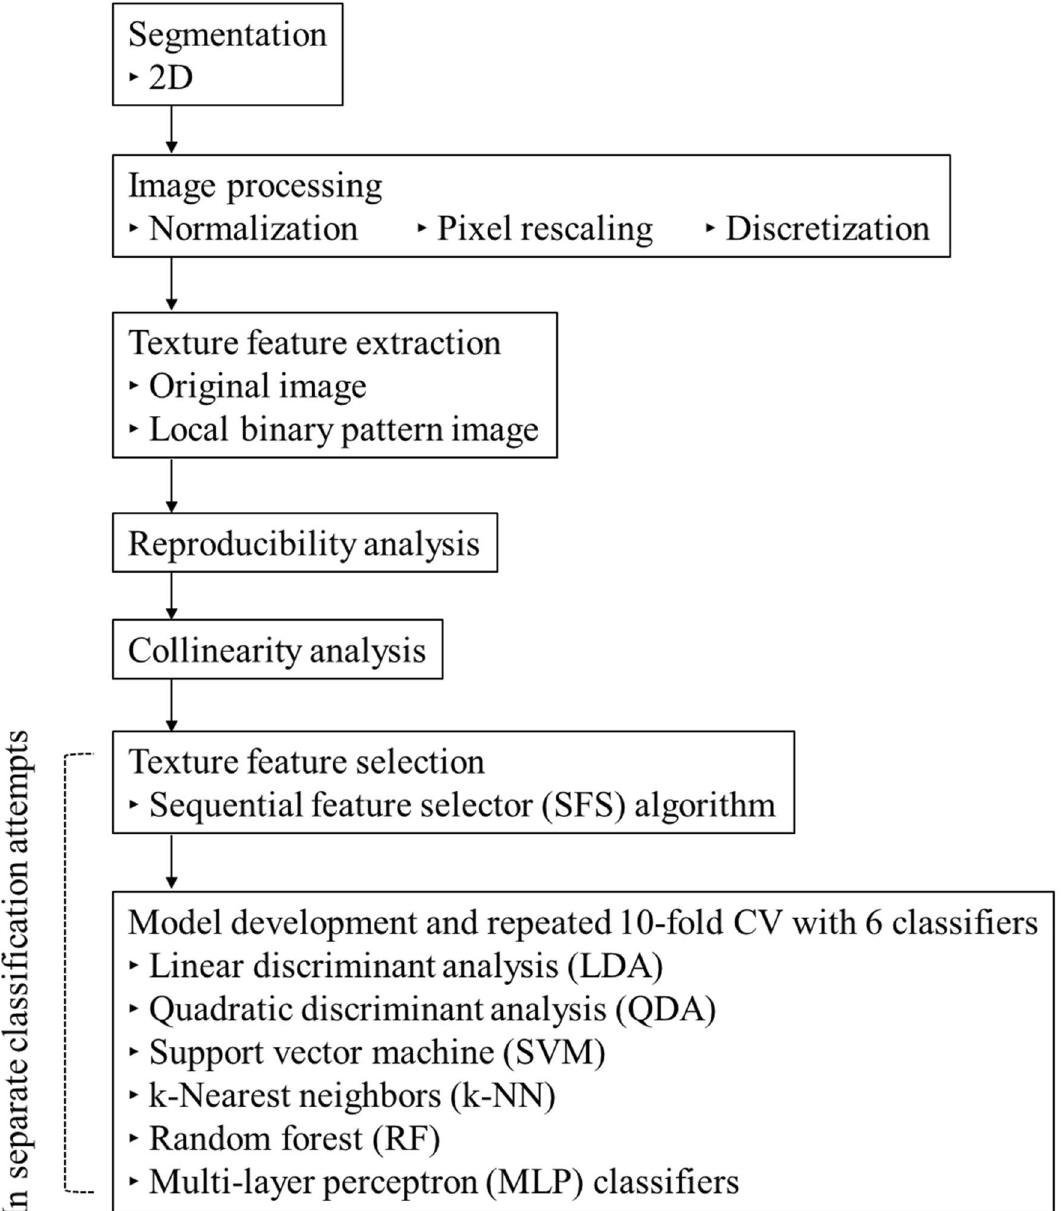
Figure 2. Flow chart showing the technical study pipeline. After segmentation, image processing, texture feature extraction, reproducibility analysis, and collinearity analysis were conducted in all datasets together, followed by texture feature selection and ML-based model construction in separate classification attempts. CV